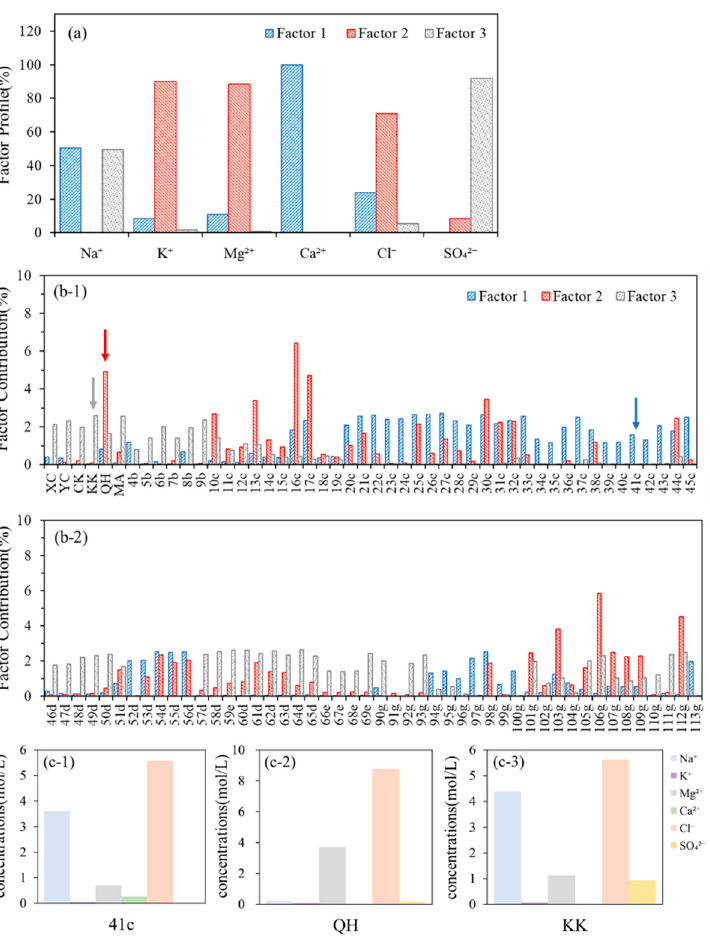
Figure 4. ( a ) Factor profiles of PMF 3 ‐ factor results on ionic concentrations. ( b ) PMF factor distributions of all brine samples. ( c ) Three factor ‐ representing samples: ( c ‐ 1 ) 41c for Factor 1, ( c ‐ 2 ) QH for Factor 2, ( c ‐ 3 ) KK for Factor 3. b from [42], c from [43,44], d from [45], e from [46], g from [47,48].